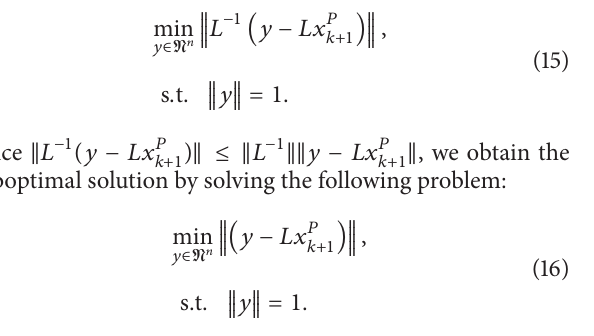
Algorithm 1. Prediction-correction method for the